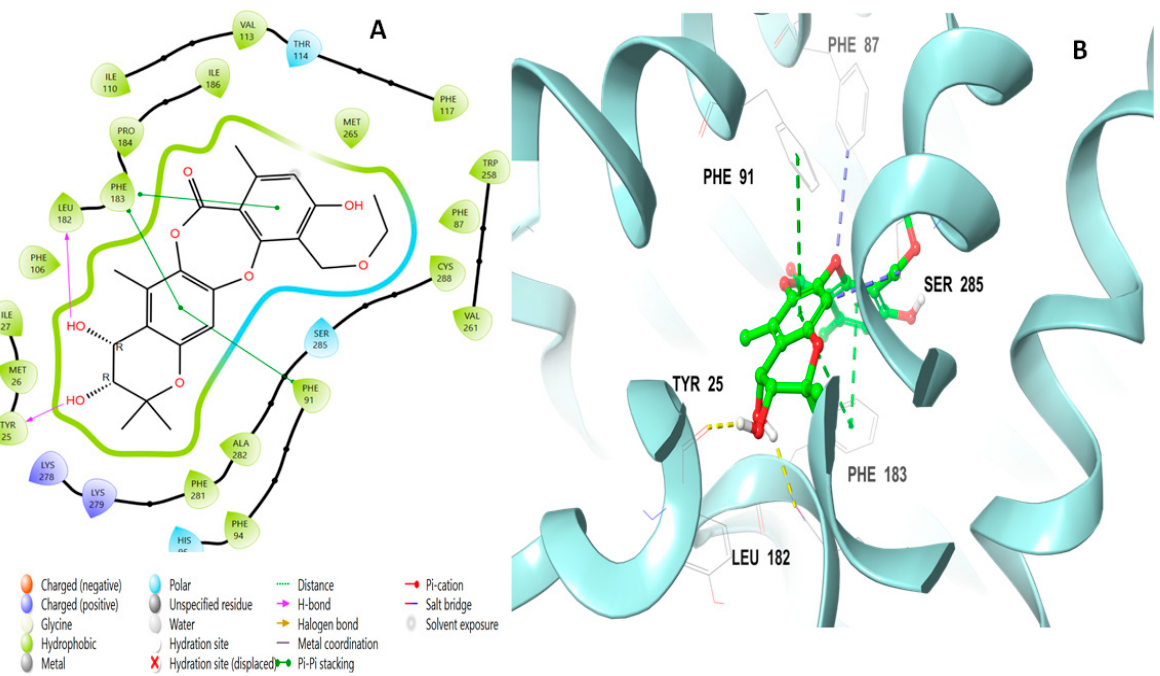
Figure 10. Putative binding mode of mollicellin P ( 100 ) at the binding site of CB2 receptor (PDB-ID: 6KPF). Mollicellin P ( 100 ) is displayed as green sticks. H bonds are displayed as yellow dotted lines, and ionic bonds as blue dotted lines. ( A ) Two-dimensional view; ( B ) three-dimensional view of CB2 complexed with mollicellin P ( 100 ).